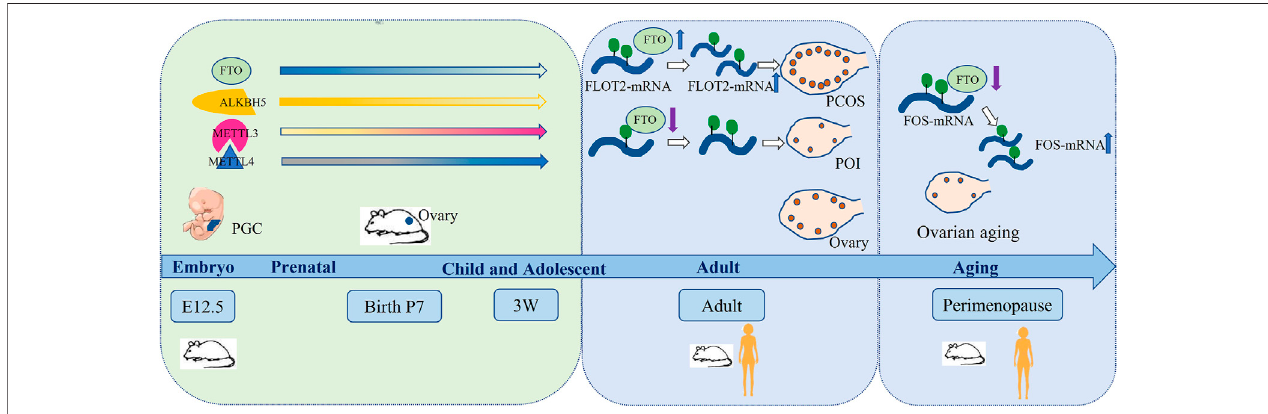
FIGURE 2 | m 6 A and regulators participates in the ovarian life